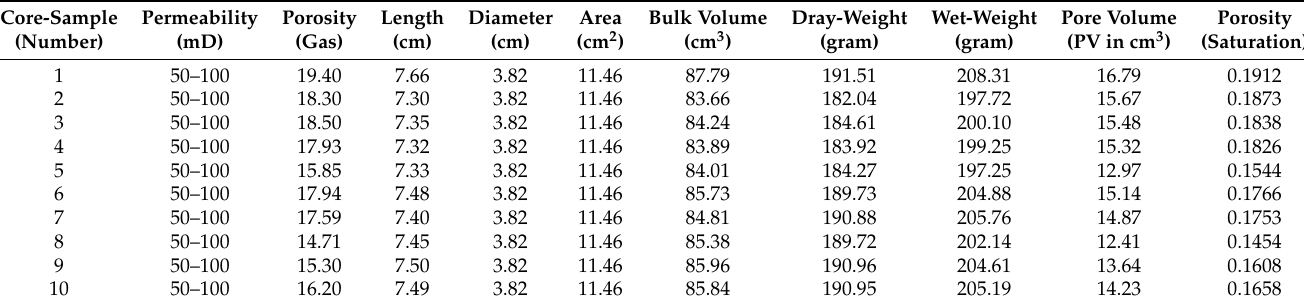
Figure 10. Indiana limestone (ILS) core sample preparation procedures using geological cutter machine, polisher, and sandpaper preparation. Table 7. Indiana Limestone (ILS) Core-sample Petrophysical